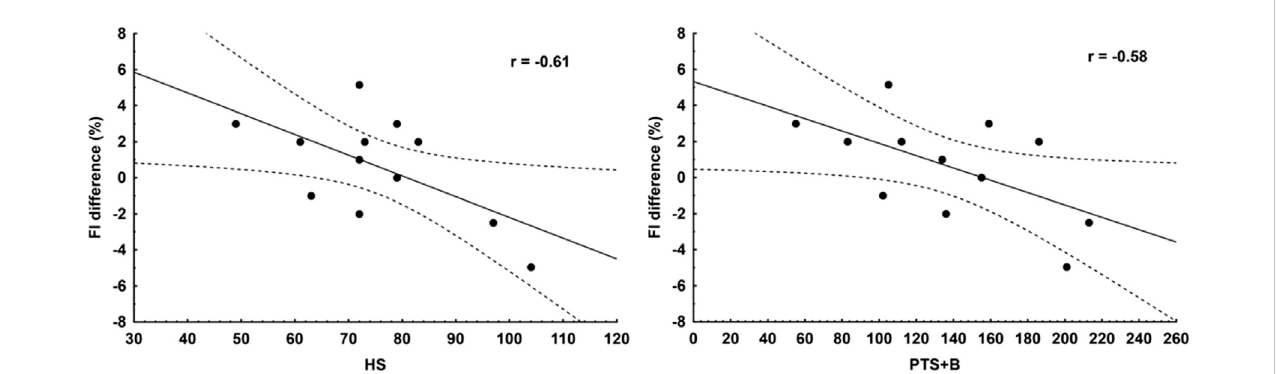
FIGURE 1 Correlation between the FI difference and the total number of heats in season (HS) and the total number of points (including bonus points) earned by competitors in all heats of the competitive season (PTS + B).